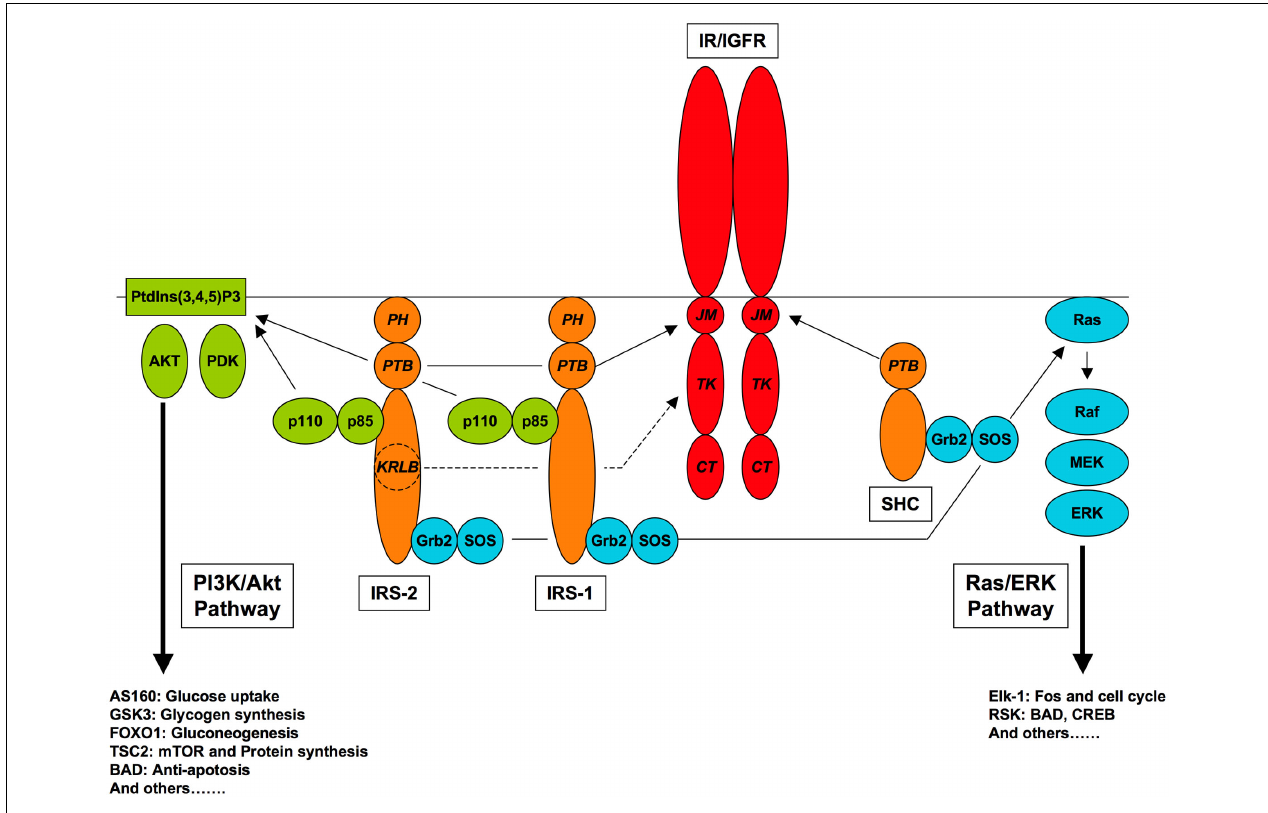
juxtamembrane; TK , tyrosine kinase; CT , carboxyl-terminal; PTB , phosphotyrosine-binding; PH , pleckstrin homology, SH2 , Src homology-2; KRLB , kinase regulatory loop